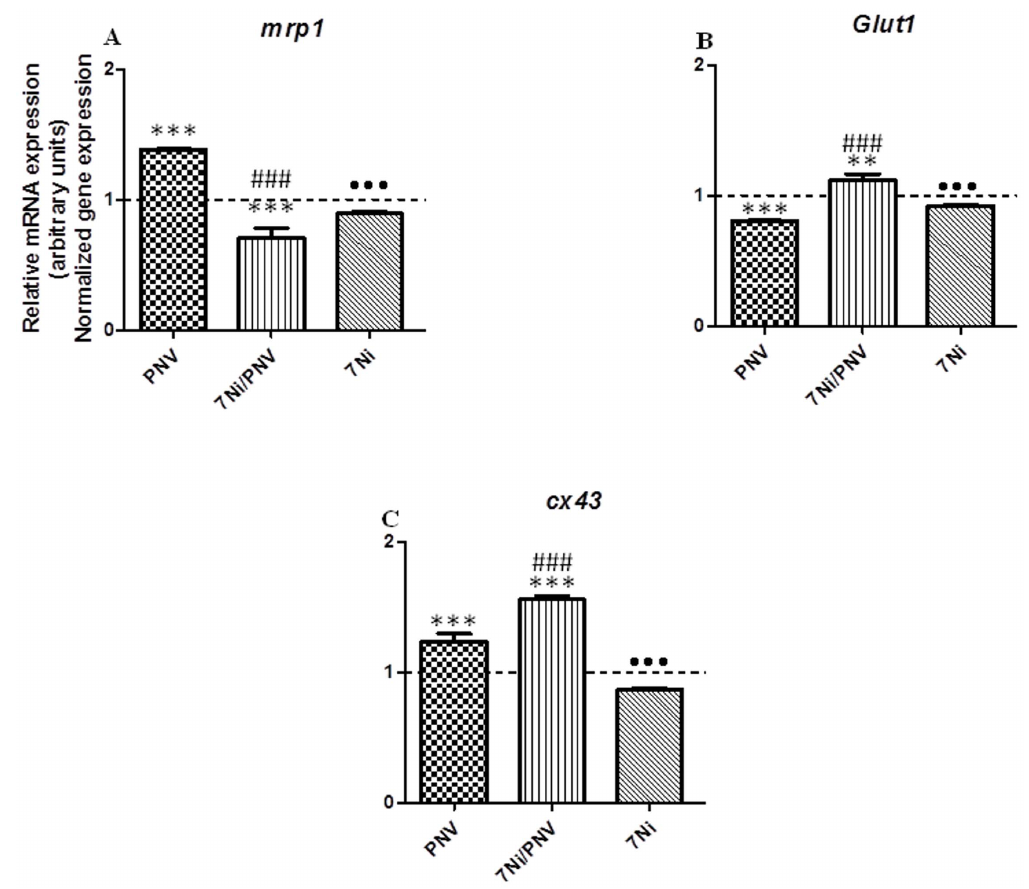
Figure 2. Effect of PNV and involvement of neuronal nitric oxide synthase in expression of mrp1, glut1 and cx43 genes, in astrocyte primary culture, by Real Time PCR. PNV increased mRNA levels of mrp1 and nNOS blockade by 7NI counteracted this effect. glut1 mRNA was decreased by PNV, but 7NI + PNV treatment also neutralized this PNV effect. However, cx43 mRNA level was increased by PNV and even more by 7NI plus PNV. In 7NI per se treated-astrocytes mrp1 gene expression was significantly above the level found in cell treated with 7NI/PNV; in contrast, glut1 and cx43 gene expression of astrocytes treated with 7NI alone was significantly below the level found in 7NI/PNV-treated cells. Fold change in genes expression was analyzed by the 2 2 DD CT method. Graphs showed relative gene expression, considering control as 1 (dotted line in graphs). Data is NNN p , 0.001 vs . 7NI/PNV). mean 6 S.D.M. (**p , 0.01 and ***p , 0.001 vs . Control; ### p , 0.001 vs . PNV;